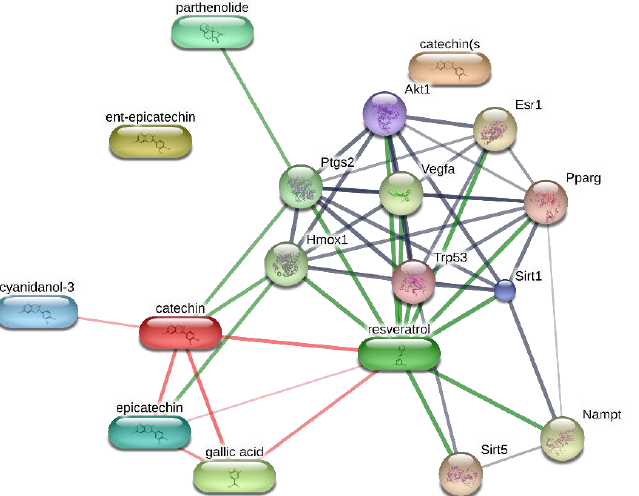
Figure 2. The targets–components analysis conducted via the STITCH platform (http://stitch.embl.de), highlighting the prominent role of cyclooxygenase-2 (COX-2/Ptgs2) in the components–targets plot.